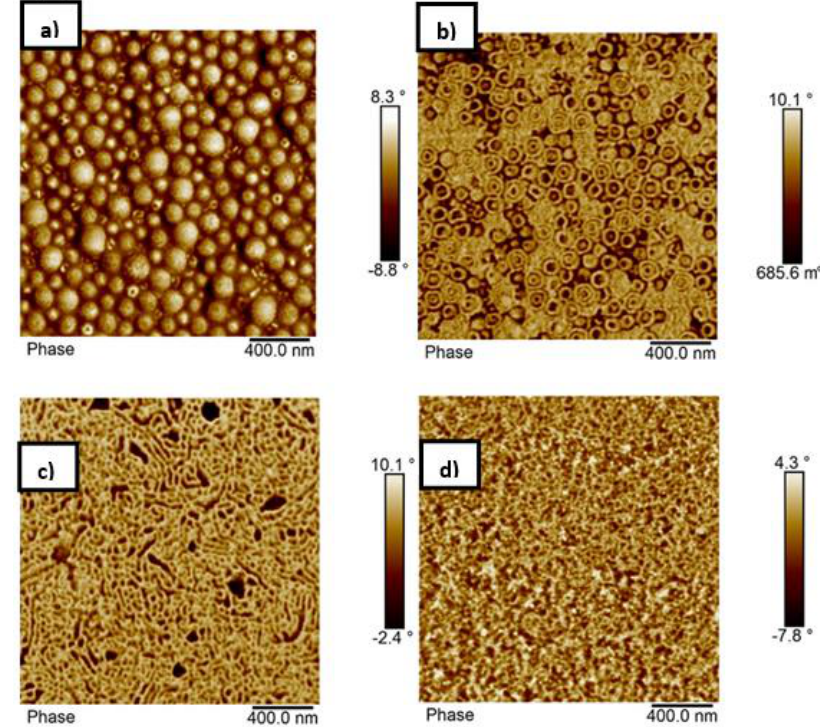
Figure 10. AFM phase images of the sample p(St25-2EHA50-St25): ( a ) top surface of the film dried at room temperature; ( b ) cross-section of the film dried at room temperature; ( c ) cross-section of the film dried at 100 °C and; ( d ) cross section of a film cast from THF solution.